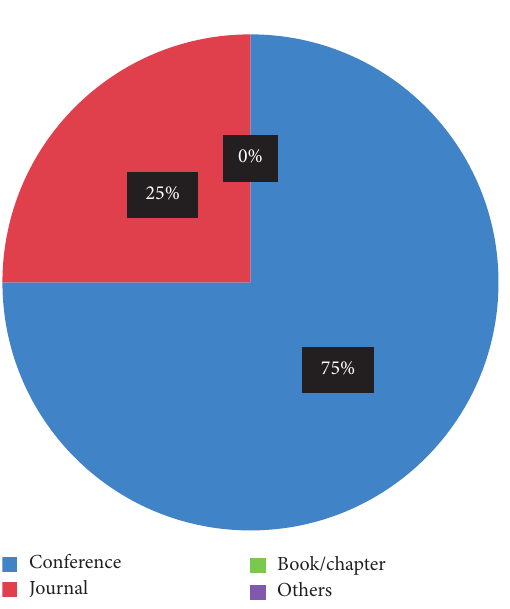
Figure 2: Type of papers along with the total number of publications.